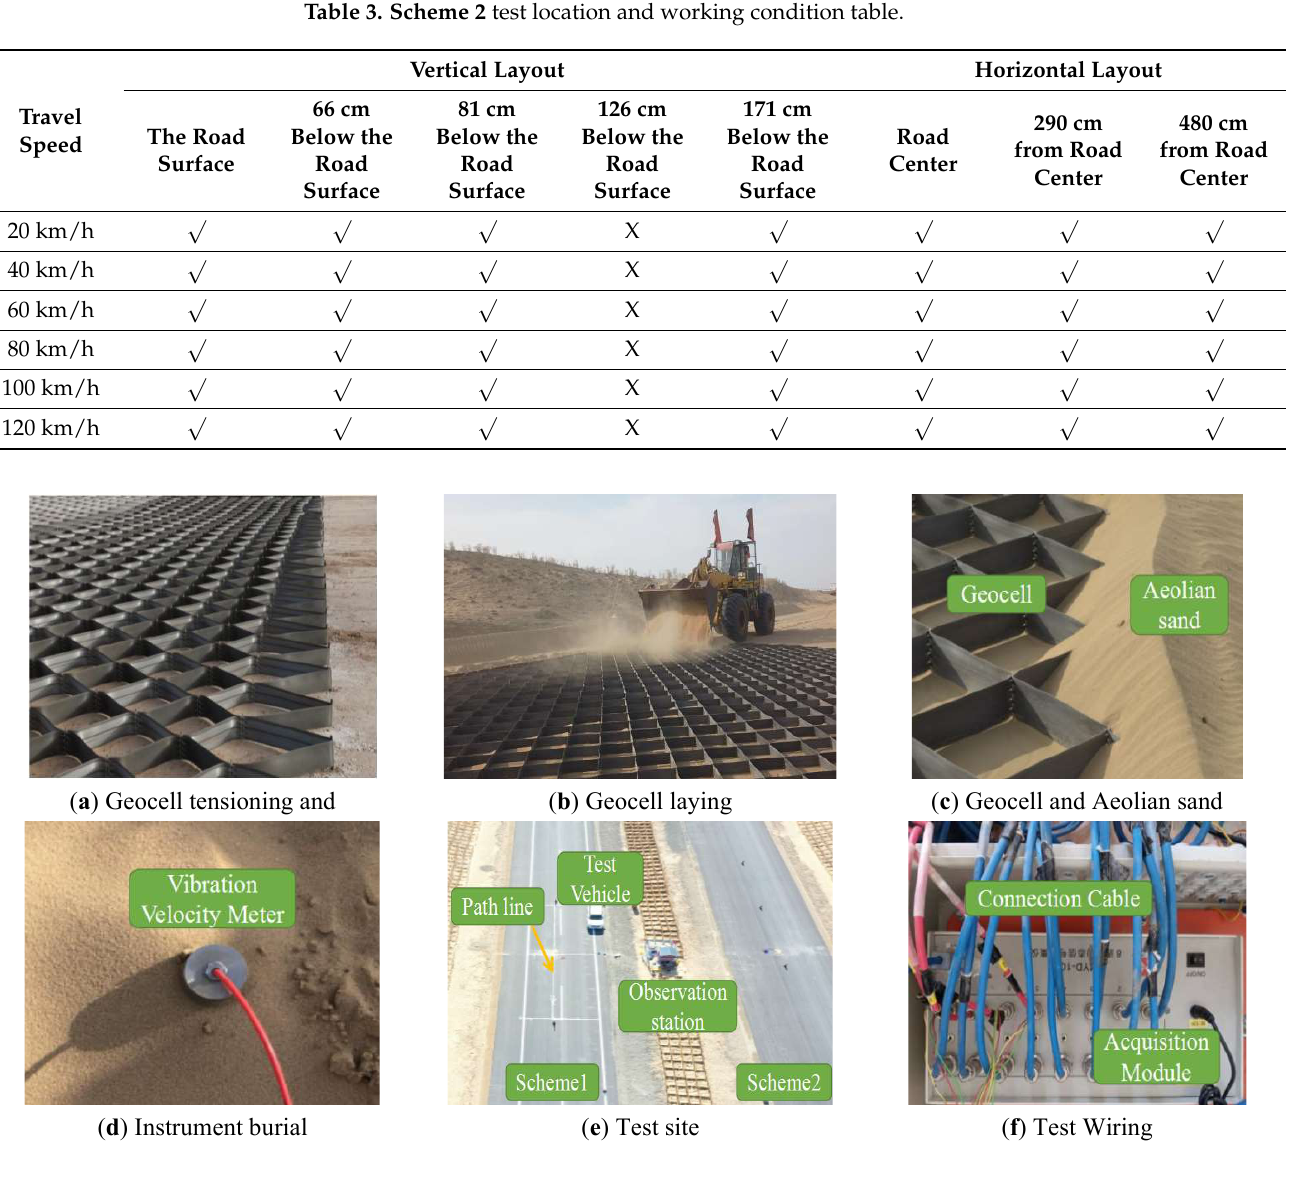
Figure 4. Test on site.